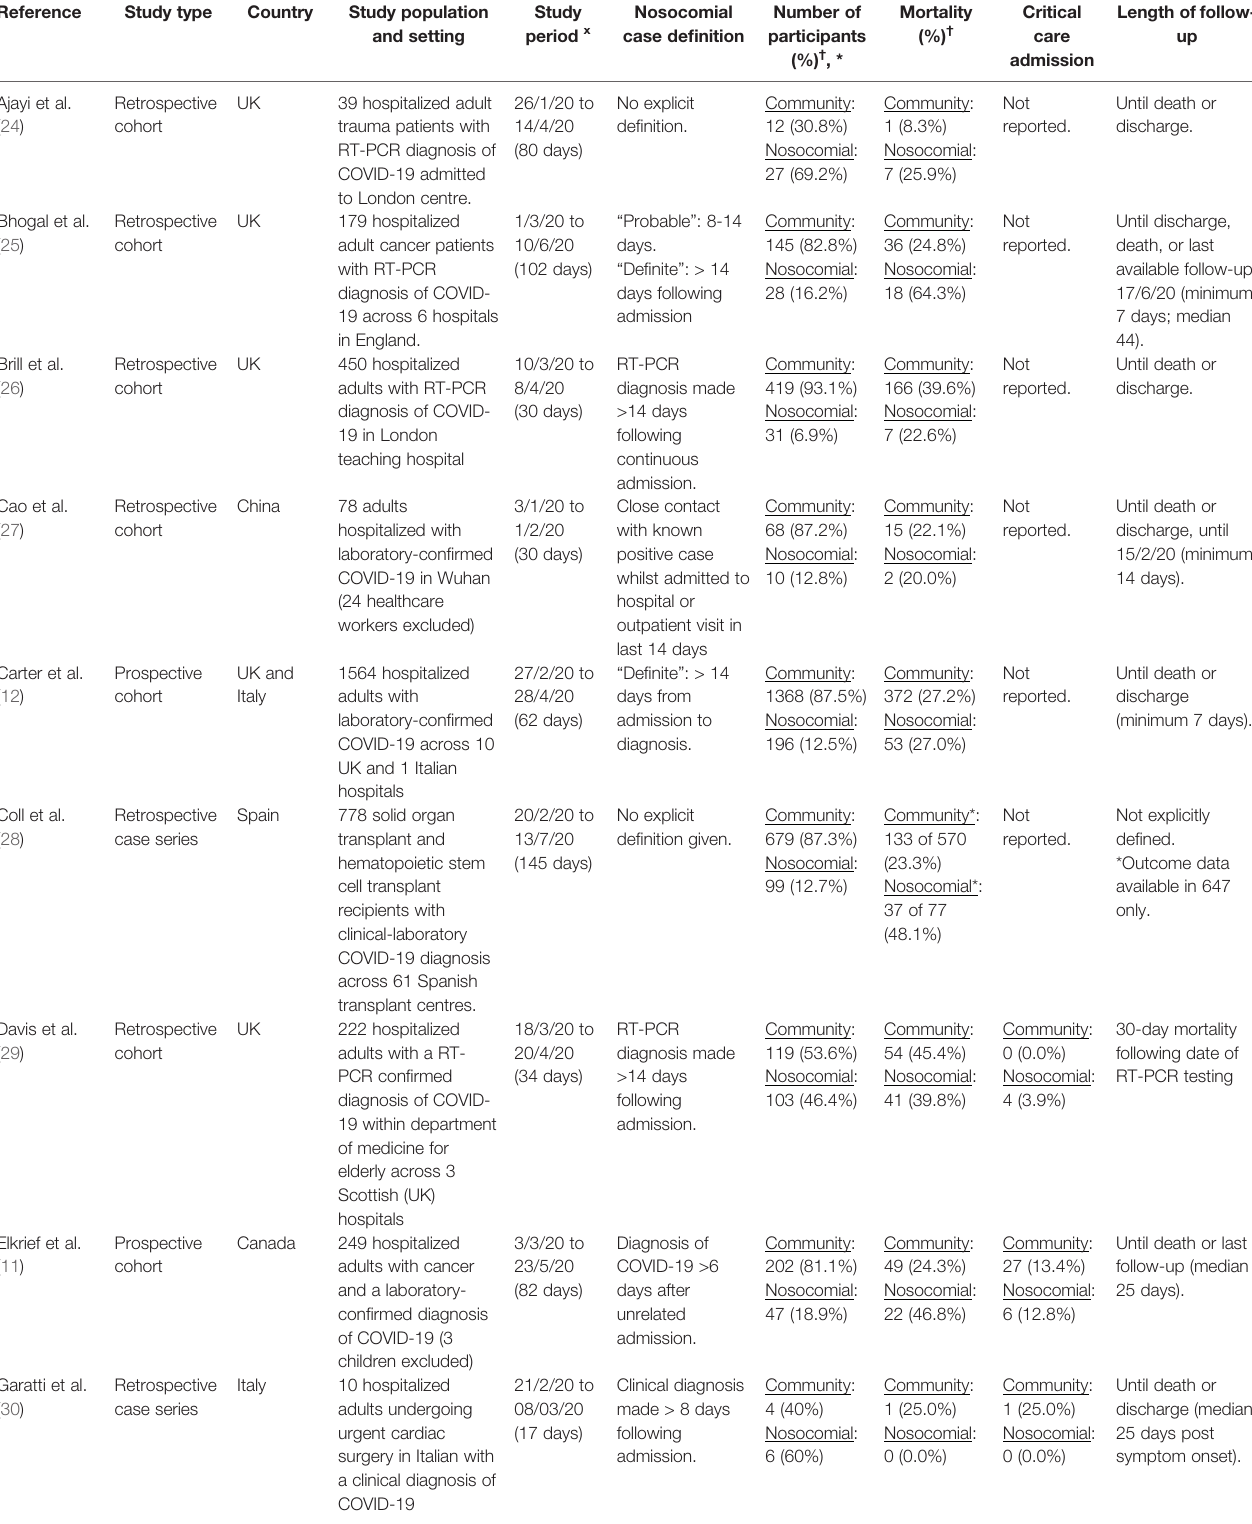
TABLE 1 | Evidence summary